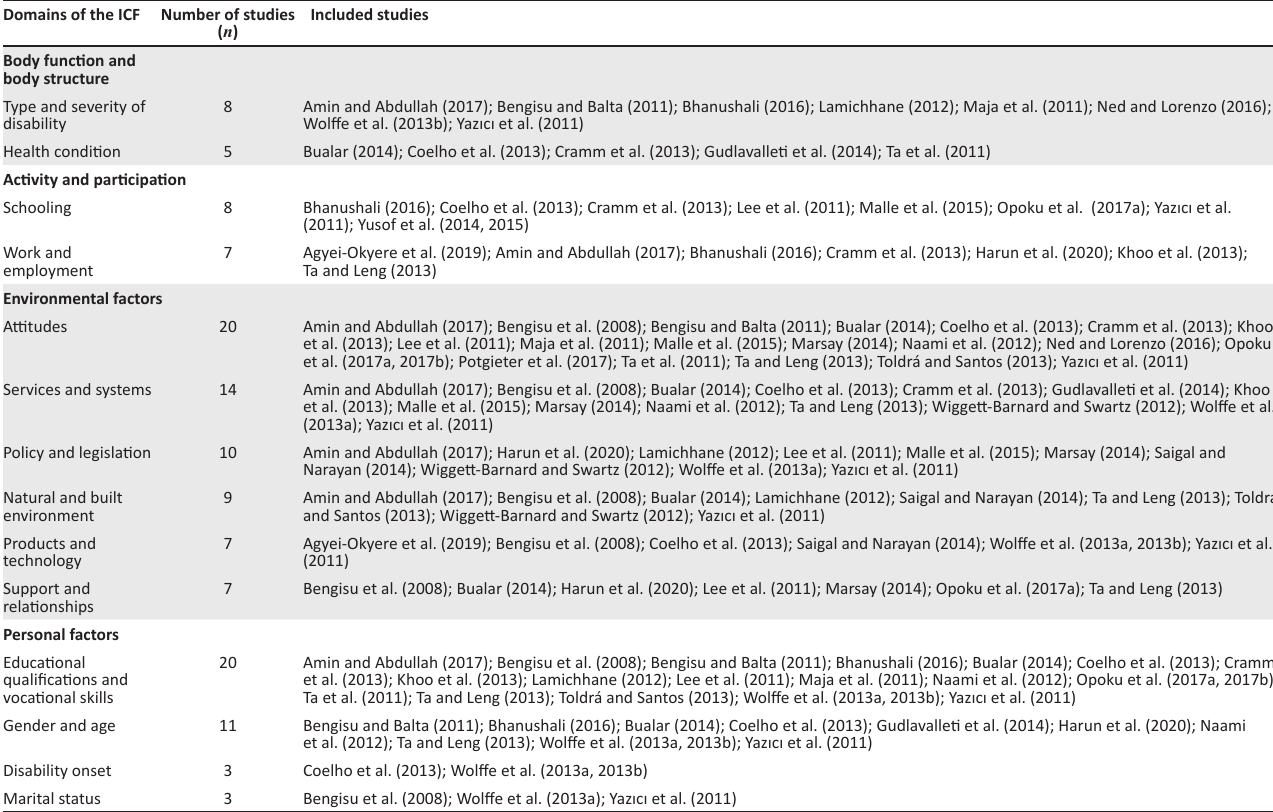
TABLE 3 : Identified factors within the International Classification of Functioning, Disability and Health framework domains. Domains of the ICF Number of studies ( n